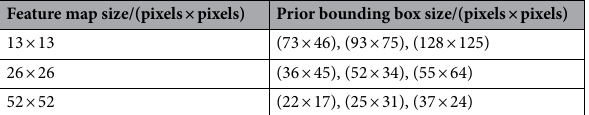
Table 1. Prior bounding boxes allocation of feature maps of different